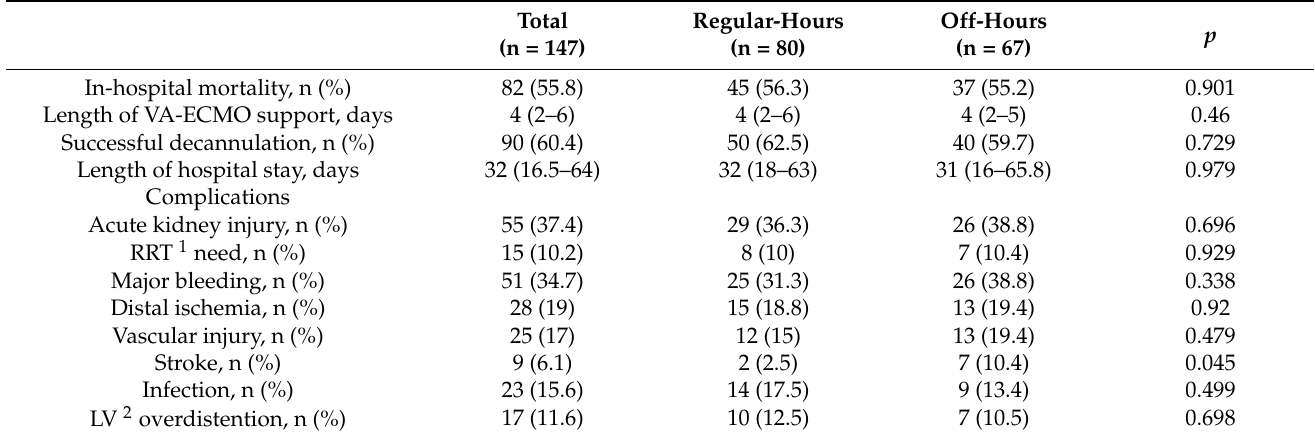
Table 2. Clinical outcomes according to the moment of venoarterial extracorporeal membrane oxygenation implantation.